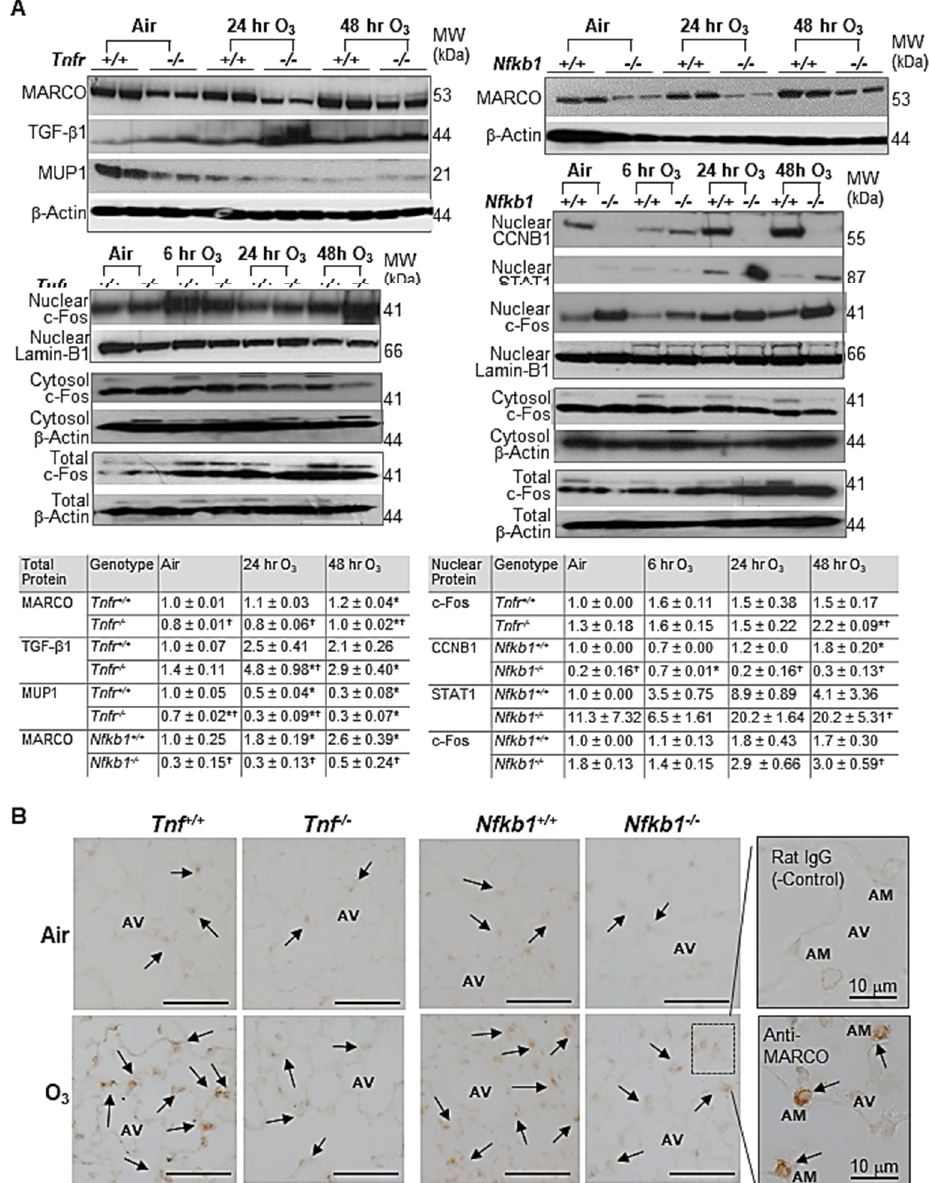
Figure 5. Microarray analysis validation of tumor necrosis factor receptor (TNFR)- and NF- κ B1- dependent transcriptomics in response to ozone (O 3 ). ( A ) Western blot analyses determined TNFR- and/or NF- κ B1-dependent expression of a lung macrophage receptor with a collagenous structure (MARCO), transforming growth factor (TGF)- β 1, major urinary protein 1 (MUP1), nuclear c-Fos, nuclear G2/mitotic-specific cyclin-B1 (CCNB1), and nuclear signal transducer and activator of transcription 1 (STAT1). β -Actin (for total and cytosol) and Lamin-B1 (for nuclear) levels detected as the